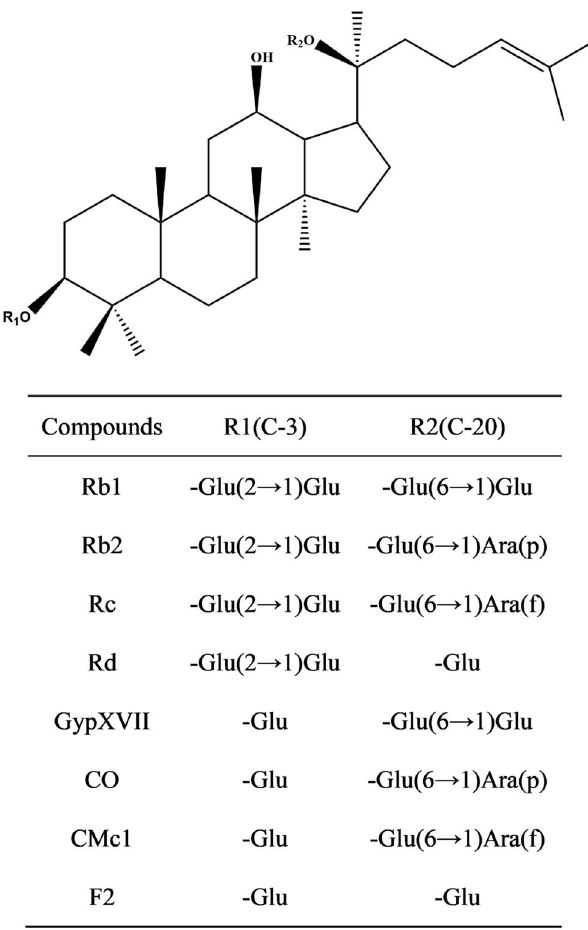
Fig. 1 Chemical structures of PPD-type ginsenosides. Glu β-D-glucopyranosyl, Arap α-L-arabinopyranosyl, Araf